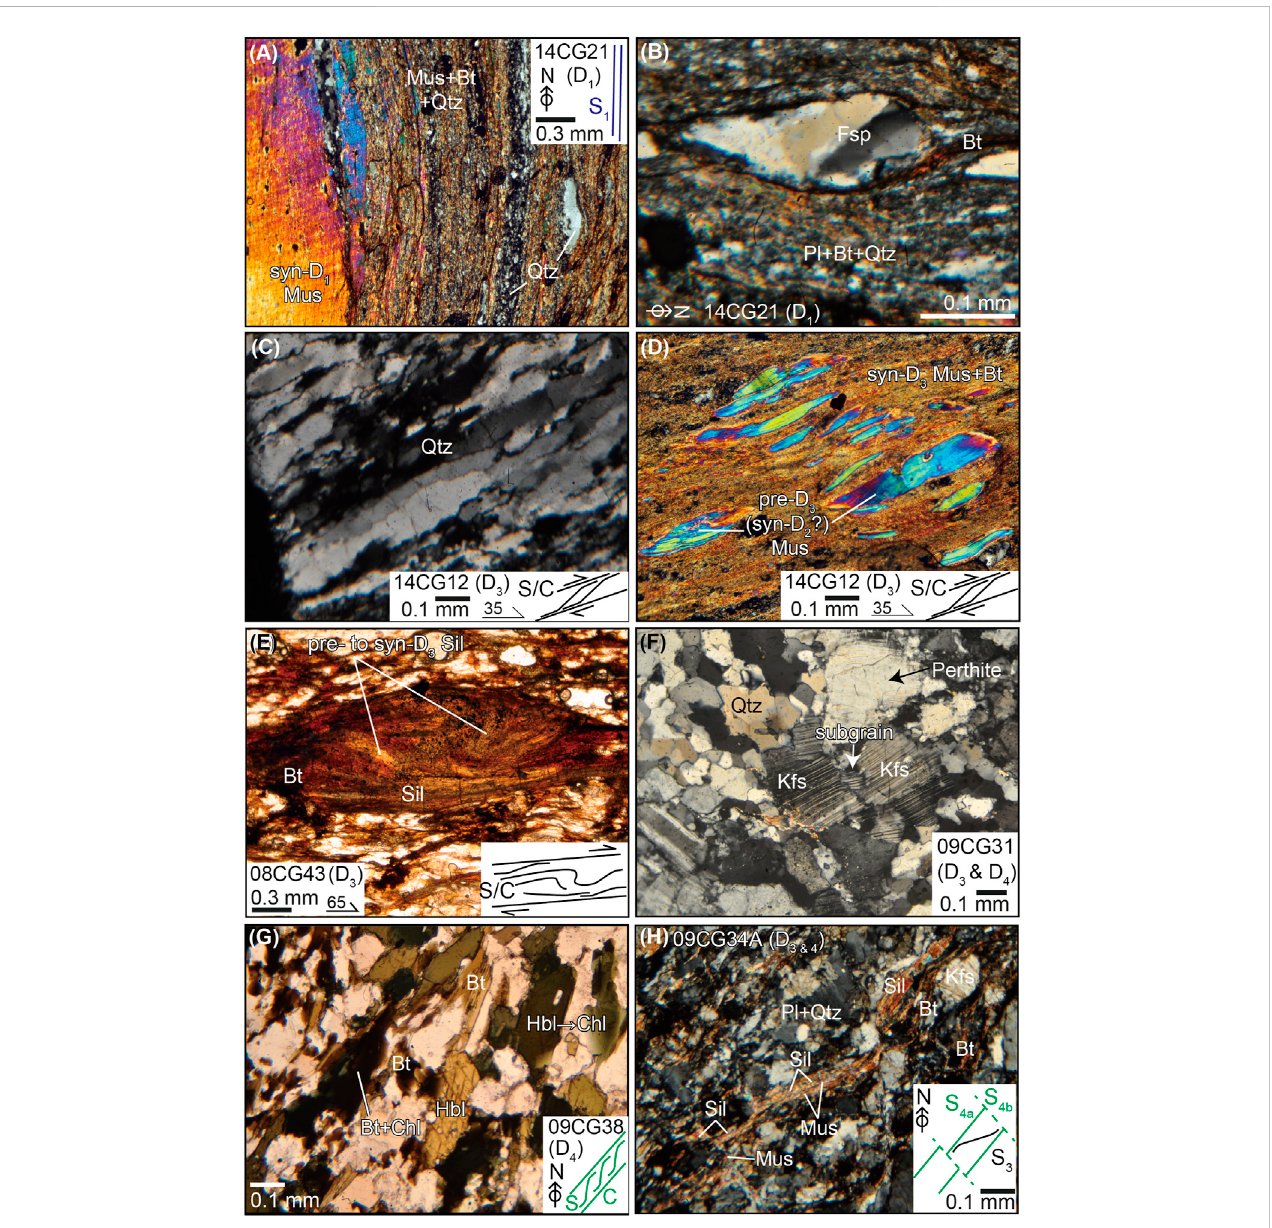
FIGURE 6 Microphotographs illustrating the microstructural and petrological relationship of D 1 to D 4 . (A) Mylonitic S 1 fabric with a right-lateral sense of shear de fi nedbymicafoliaandvery fi ne-grainedquartz+feldsparaggregatesintheribbon.Thedeformationmechanismoftherelicofquartzribbon(theleftside)is the grain boundary migration. (B) Right-lateral sense of shear of D 1 can be indicated by the biotite, which wrapped the pressure shadow of the bulged K-feldsparwithunduloseextinction. (C) GrainboundarymigrationofquartzwasobservedfromtheC-fabric-parallelribbonwithunduloseextinction. (D) Mylonitic S/C fabric is de fi ned by muscovite + biotite folia and mica fi sh with a sub-horizontal thrust component. (E) Mylonitic S/C fabric is de fi ned by biotite folia.Thebiotite fi shcontainfoldedsillimaniteinclusions. (F) Microphotographshowingpre-tosyn-D 3 subgrain-rotatedK-feldspar. (G) MyloniticS/C 1 fabricis de fi nedbychlorite+biotite±chloritizedhornblendewithadextralsenseofshear. (H) S 3 isde fi nedbysillimanitefolia,whichareboundbyNE-SW-strikingS 4a foliationde fi nedby fi ne-grainedmuscoviteandplagioclaseandquartzaggregates.Truncation andoffsetsofbothS 3 andS 4a byS 4b fracturescanbenoted.Bt, biotite; Chl, chlorite; Fap, feldspar; Hbl, hornblende; Kfs, K-feldspar; Mus, muscovite; Pl, plagioclase; Qtz, quartz; and Sil,